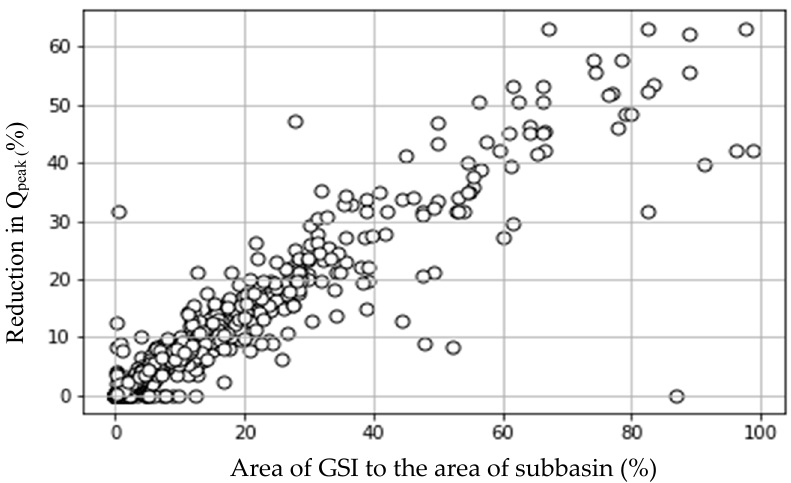
Figure 5. The relation between area of GSI and reduction in peak runoff discharge.